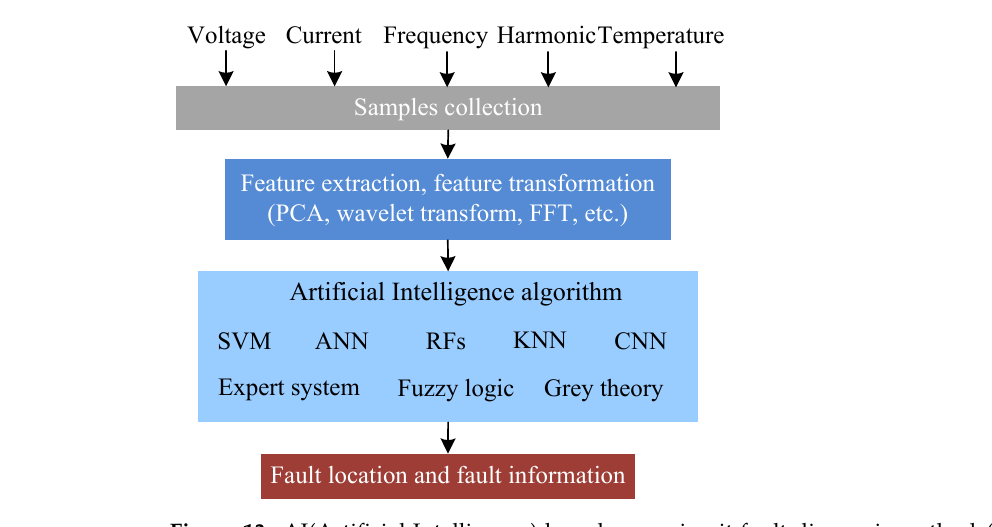
Figure 13. AI(Artificial Intelligence)-based open-circuit fault diagnosis methods(ANN: Artificial Neural Network; CNN: Convolutional Neural